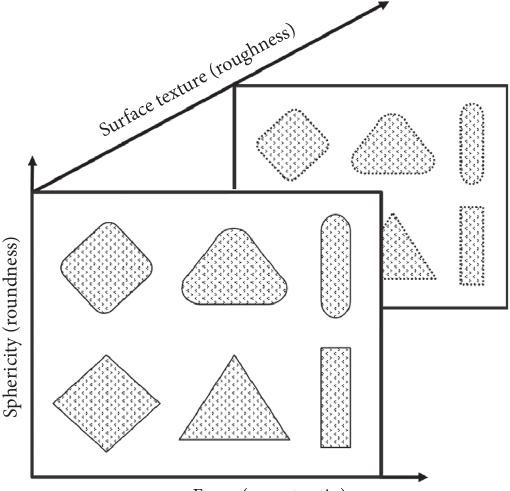
Figure 6: A simplified representation of form, roundness, and surface texture by three linear dimensions to illustrate their independence (modified after Barrett